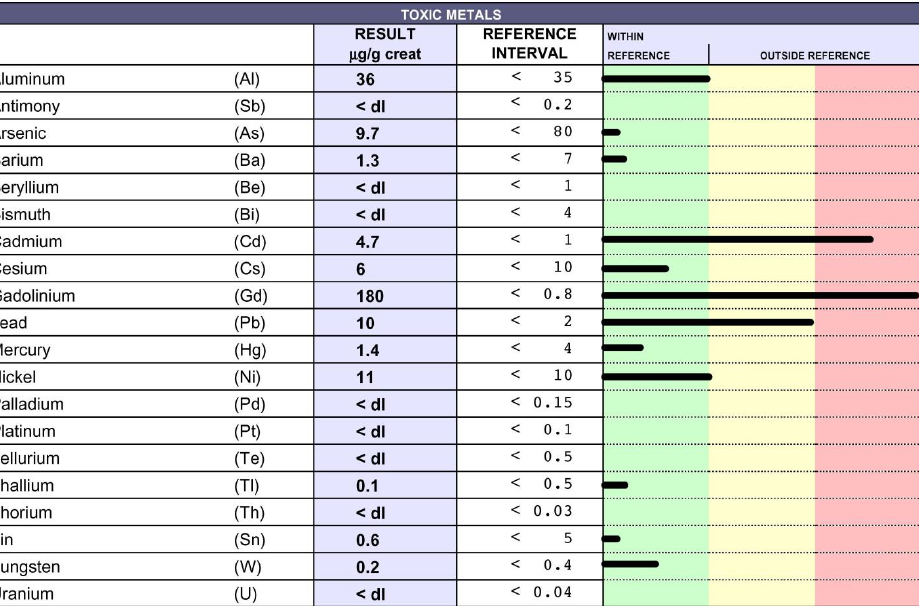
Figure 3. Detection of TMs in the urine samples of IM: IM gave consent to the chelation therapy; thus, the presence of TMs was detected in her urine samples following challenge with EDTA, using inductively coupled plasma mass spectrometry. The chelation test displayed very high levels of Cd, Pb, and Gd.